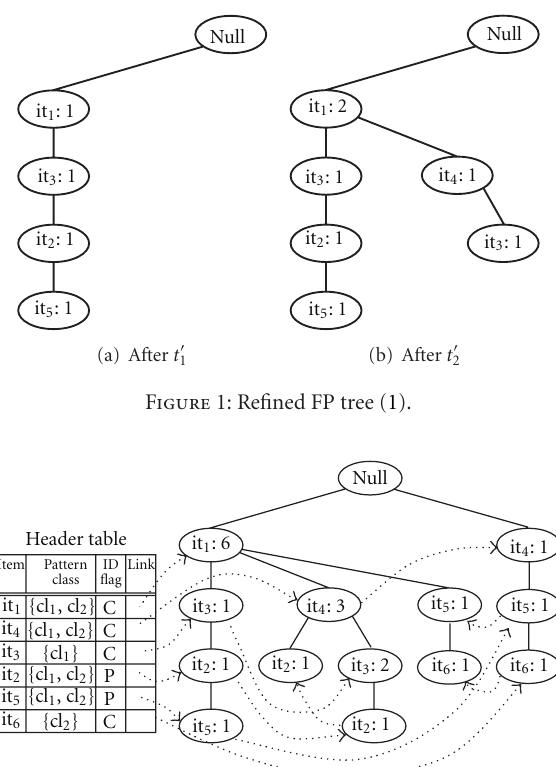
Figure 2: Refined FP tree (2).